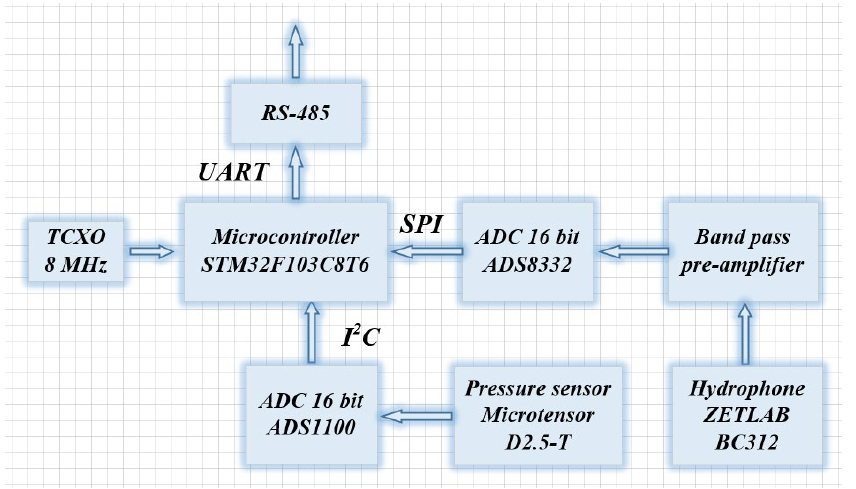
Figure 6. Block diagram of the surface part of the beacon.